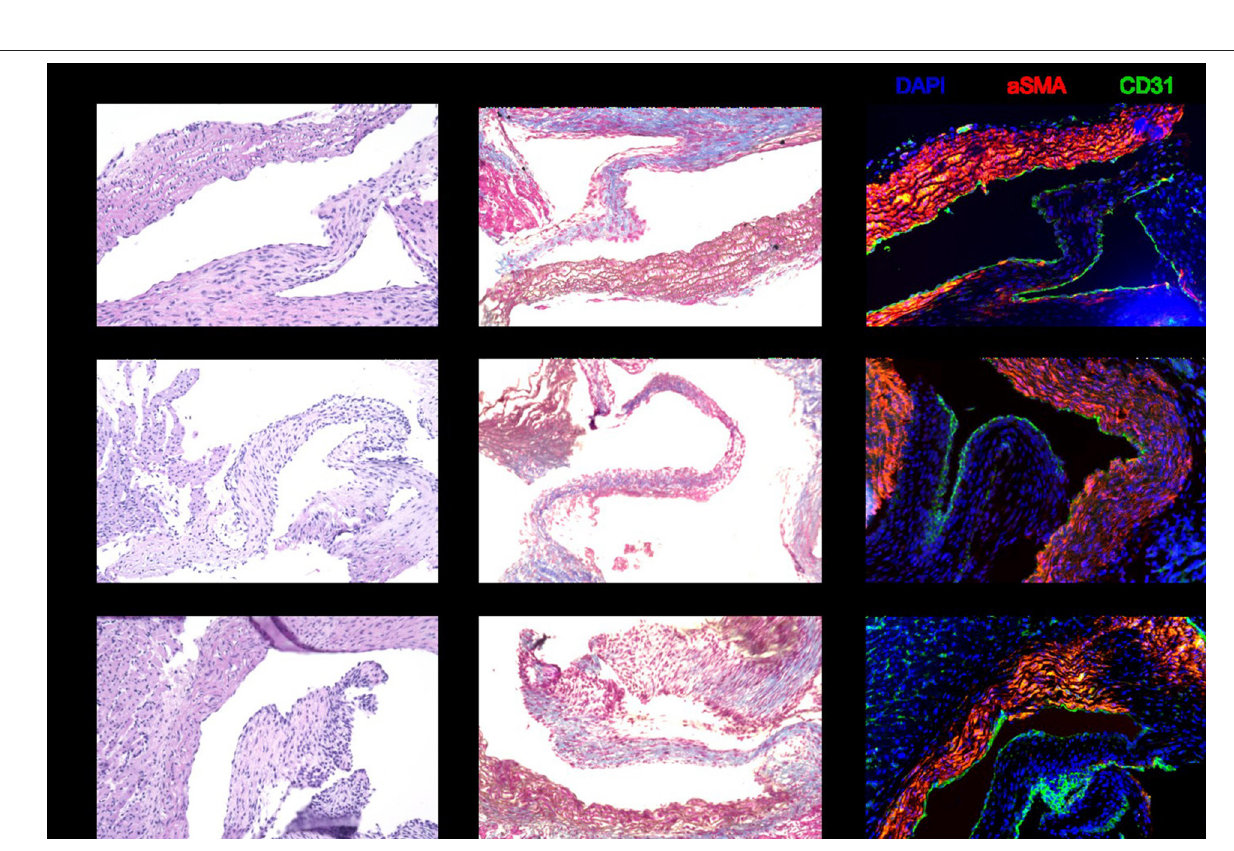
FIGURE 3 | Representative sections stained with hematoxylin and eosin, Masson trichrome, and immunohistochemistry for DAPI, aSMA, and CD31. There are no structural differences in the donor heart valves between 6, 24, and 48h of cold